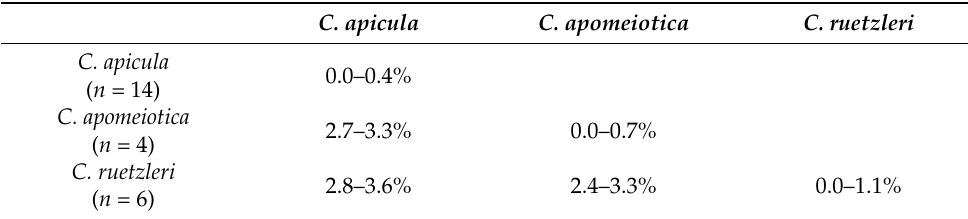
Table 3. Pairwise rbc L sequence divergences between the closely related species Caloglossa apicula , C. apomeiotica , and C. ruetzleri